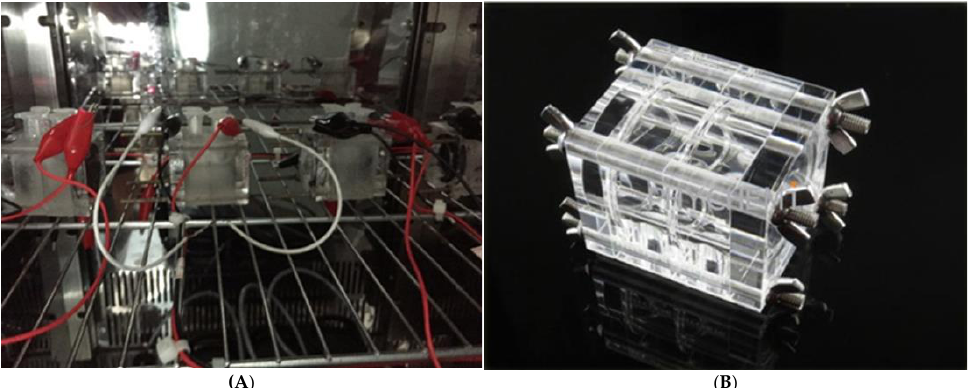
Figure 1. Single-chamber air cathode of microbial fuel cell (MFC). ( A ) presented the real operation condition in a constant incubator; ( B ) illuminated the Plexiglas structure of a single chamber air cathode before operation.